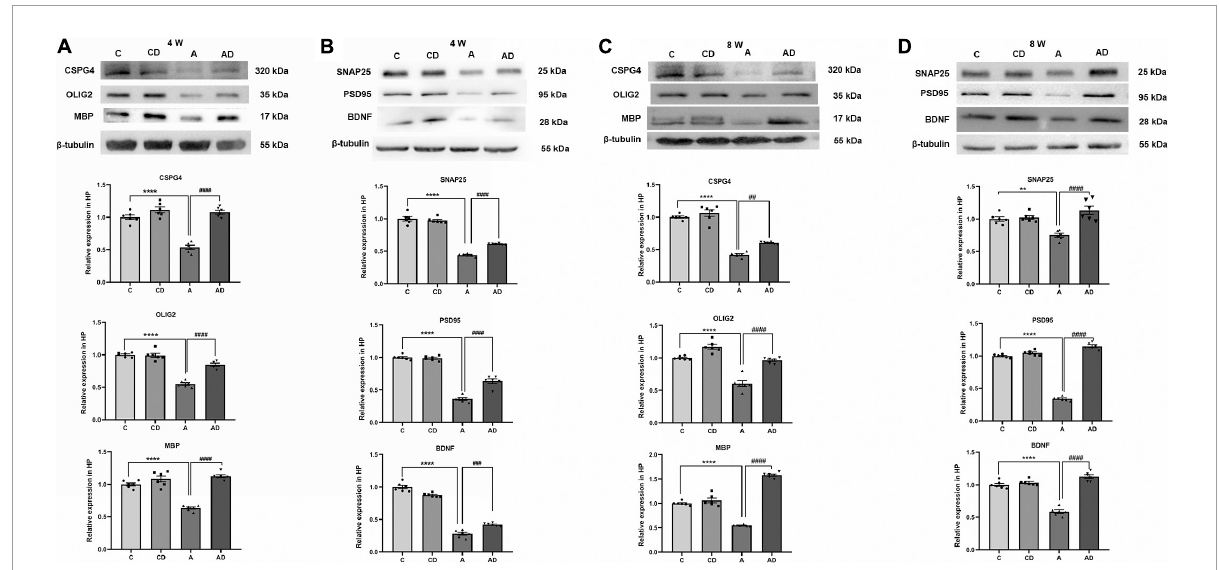
FIGURE6 Effects of Disodium cromoglycate (DSCG) and general anesthesia (GA) on oligodendrocytes and synapses in hippocampus. (A) Representative western blot images and graphic presentation of CSPG4, oligodendrocyte transcription factor 2 (OLIG2) and myelin basic protein (MBP) protein abundance in 4 Weeks mice. (B) Representative western blot images and graphic presentation of synaptosomal associated protein 25 kDa (SNAP25), postsynaptic density protein 95 kDa (PSD95) and brain-derived neurotrophic factor (BDNF) protein abundance in 4 Weeks mice. (C) Representative western blot images and graphic presentation of CSPG4, OLIG2, and MBP protein abundance in 8 Weeks mice. (D) Representative western blot images and graphic presentation of SNAP25, PSD95, and BDNF protein abundance in 8 Weeks mice. Results are median ± S.E.M ( n = 6) with the presence of individual animal data in the bar graphs. Results were analyzed by one-way analysis of variance (ANOVA) followed by the Tukey’s test. ** P < 0.01, **** P < 0.0001 compared with C group. ## P < 0.01, ### P < 0.001, #### P < 0.0001 compared with A